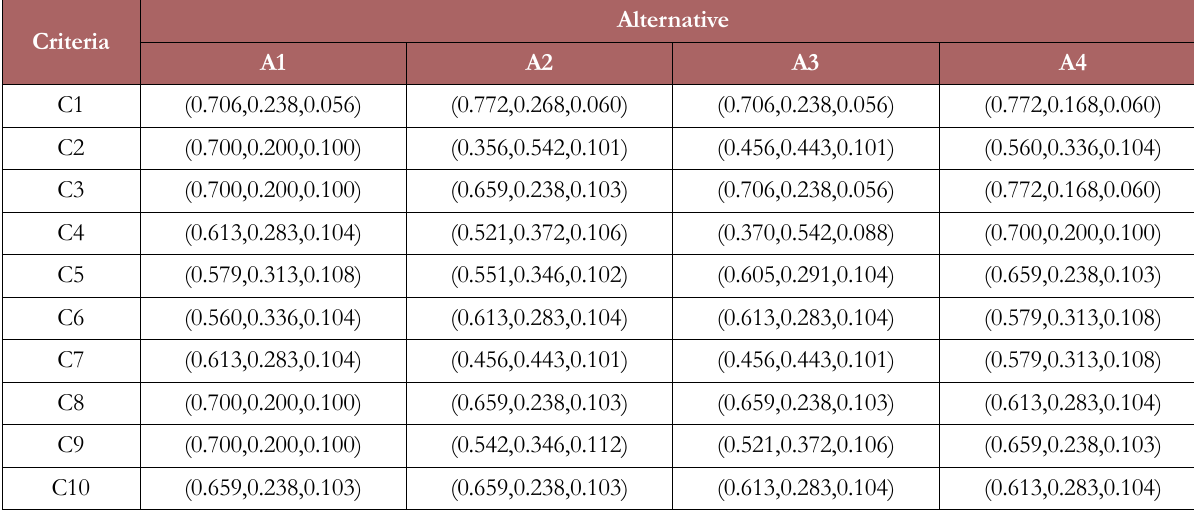
Table 17. Aggregated intuitionistic decision